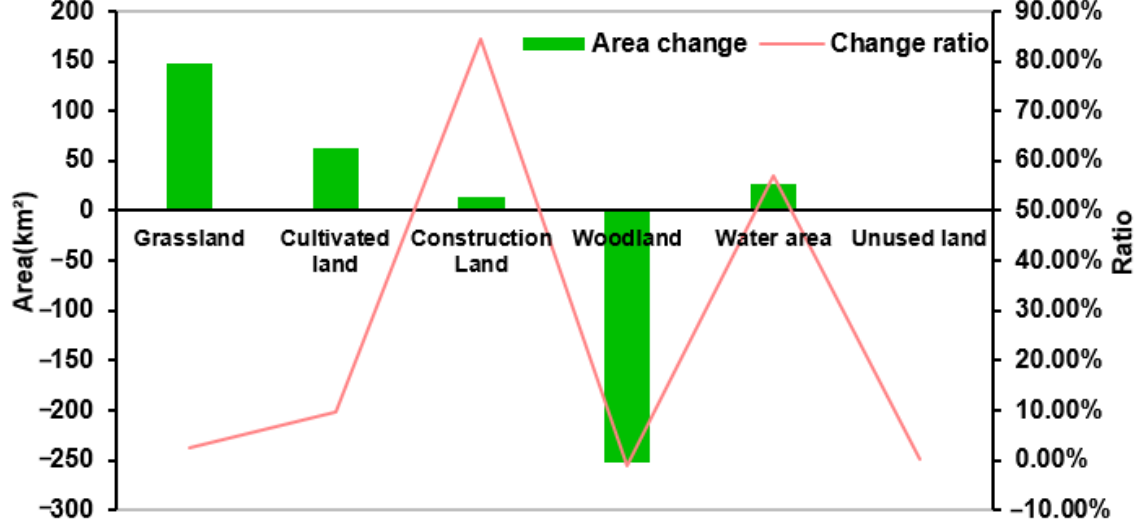
Figure 4. Changes in the area and ratio of various land-use types from 2000 to 2010.